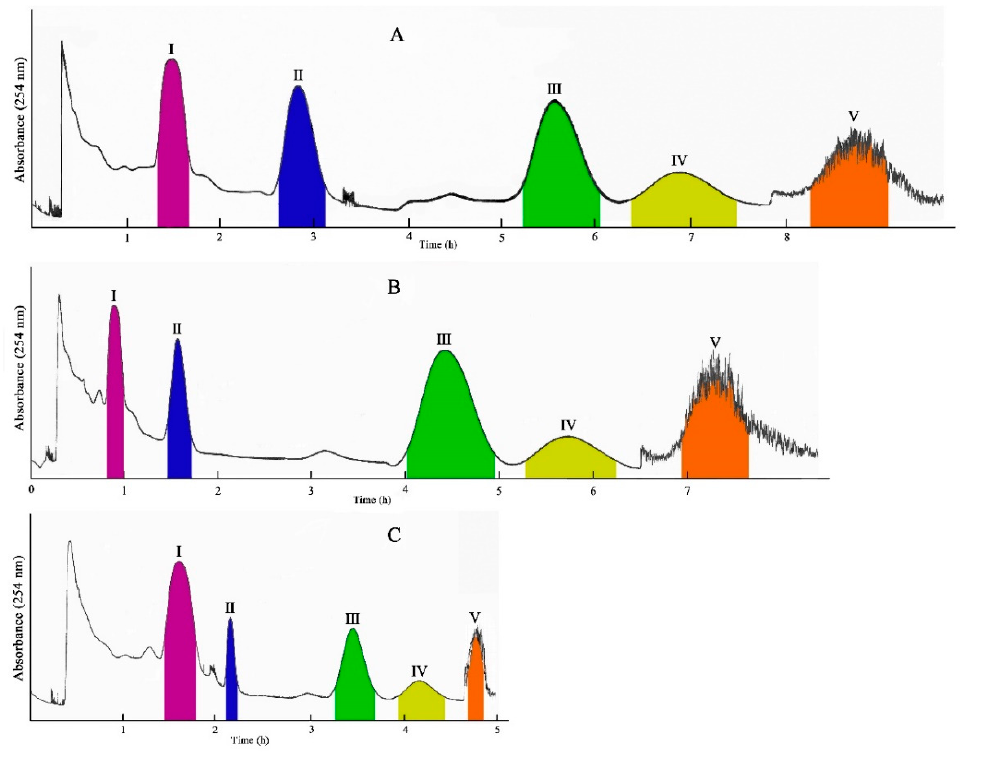
Figure 2. HSCCC chromatogram of the crude sample from aerial parts of Salvia miltiorrhiza Bunge. Flow rate: ( A ) 2.0 → 4.0 mL/min, ( B ) 4.0 → 10.0 mL/min, ( C ) 2.0 → 10.0 mL/min; stationary phase: upper phase; mobile phase: lower phase; revolution speed: 800 rpm; detection wavelength: 254 nm; separation temperature: 25 °C.